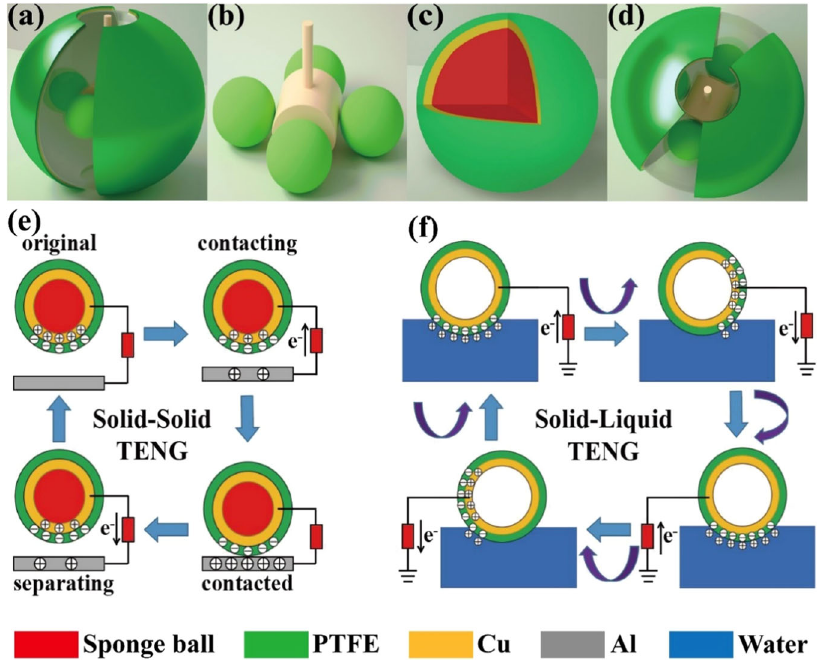
Fig. 1 Schematic illustration of the design and principle of S-TENG. a Schematic illustration of the S-TENG. b Schematic structure of S-TENG in the inner. c Detailed structure of sponge balls. d Overhead view of the S-TENG. Operation principle of the inner solid – solid TENG ( e ) under contact – separation mode. Operation principle of the outer solid-liquid TENG ( f ) under single electrode